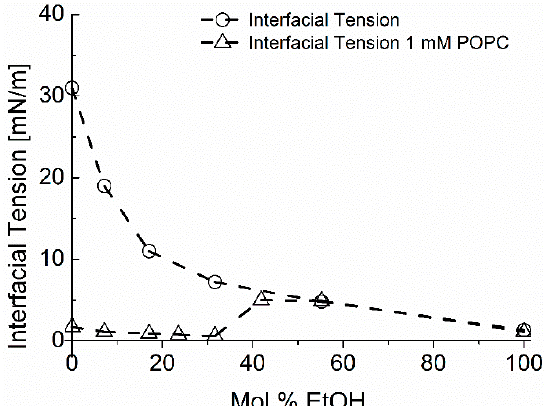
Figure 28. Interfacial tension of Triolein vs. ethanol ‐ water mixtures across the entire binary regime in absence and presence of 1 mM palmitoyl ‐ oleoyl ‐ phosphatidylcholine (POPC). Open circles show the interfacial tension of Triolein against water ‐ ethanol with increasing ethanol mol%. Open triangles show the measured interfacial tension of Triolein against water ‐ ethanol in the presence of 1 mM POPC, present as liposomes in the aqueous solution. The sharp bend for the interfacial tension in the presence of POPC at around 40 mol% ethanol represents the limit of solubility of POPC in the ethanol ‐ water mixture.